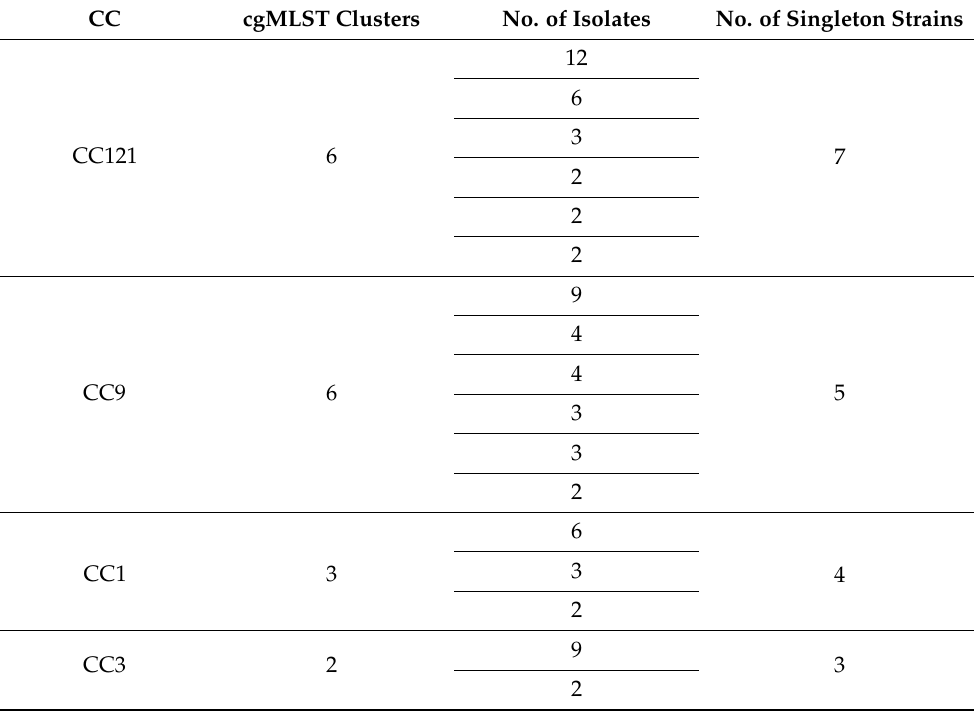
Table 4. cgMLST analysis: number of isolates within cgMLST clusters observed in each clonal complex (CCs) presenting more than one